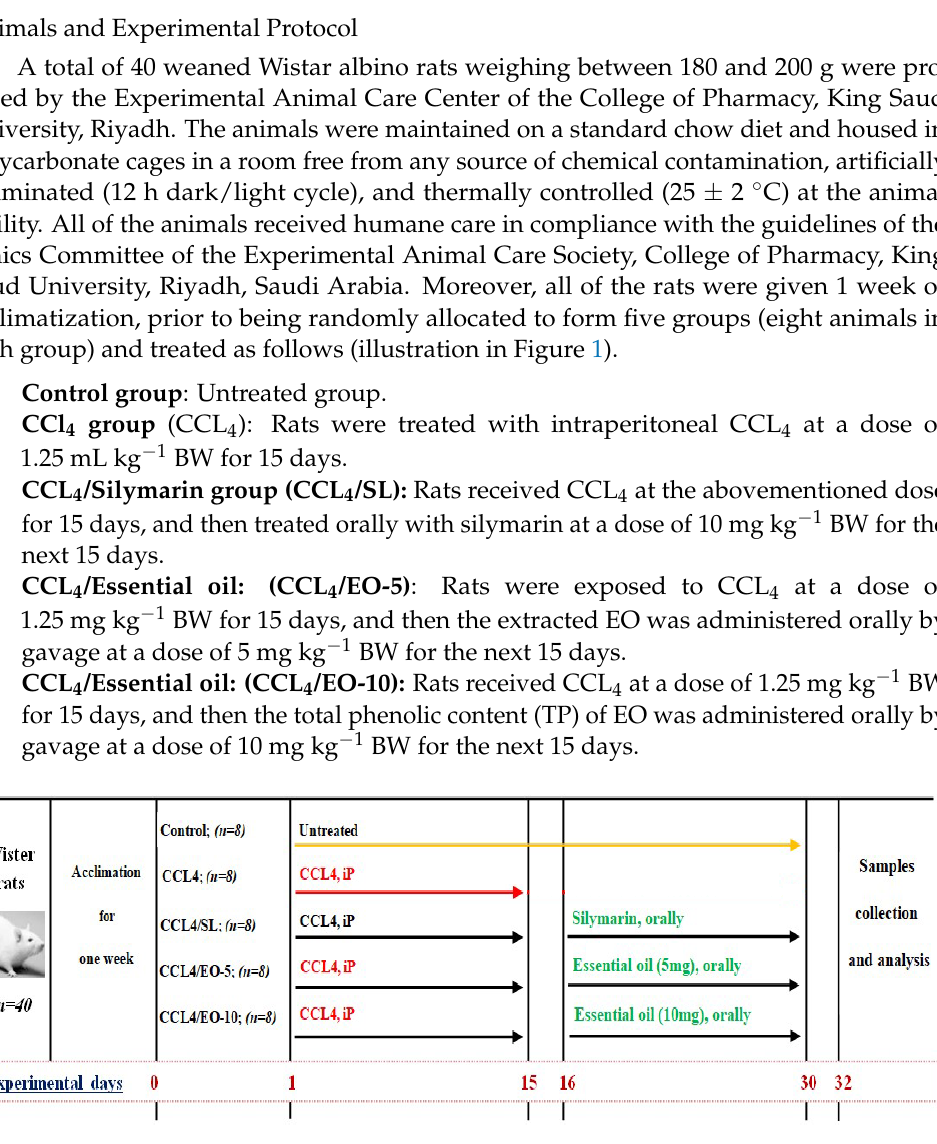
Figure 1. Scheme of the experimental protocol CCL 4 : Carbon tetrachloride; SL: Silymarin; iP: Intraperitoneal.